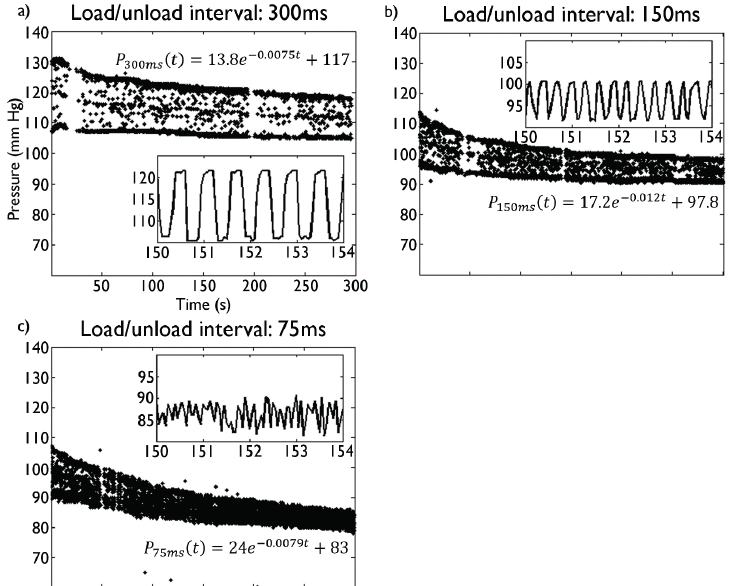
Figure 2. Dynamic load trials with load/unload pressures of 132 and 110 mm